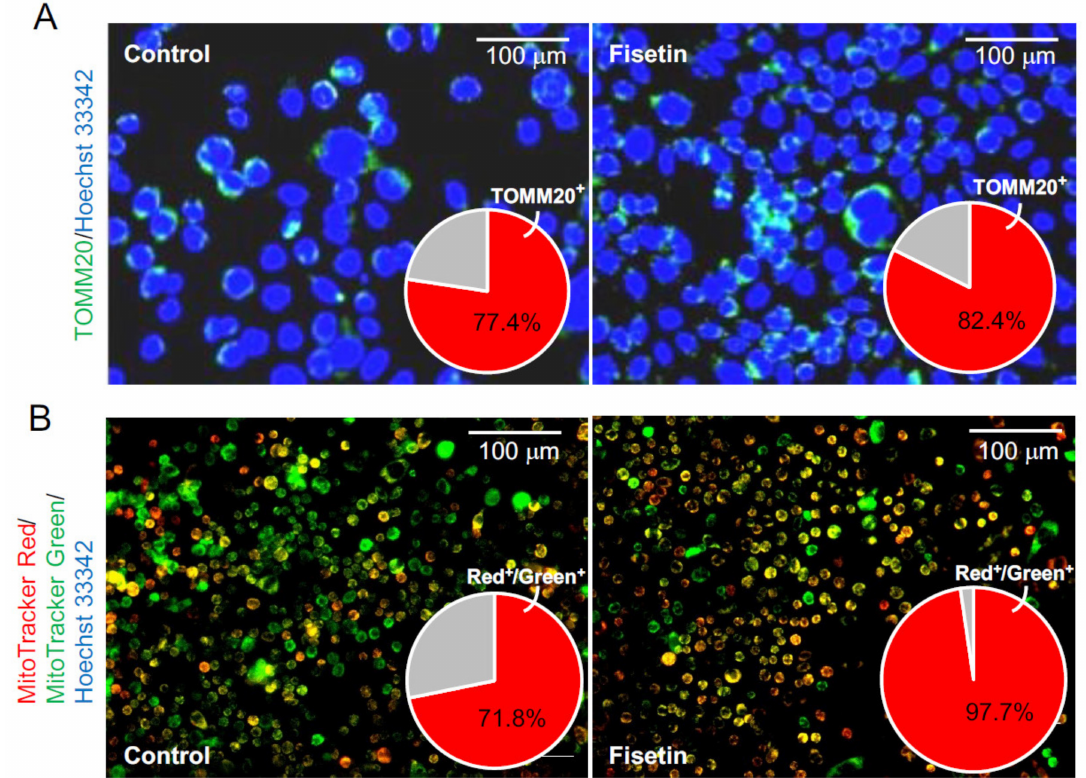
Figure 5. Effects of exosomes derived from fisetin-treated keratinocytes on the mitochondria in HFSCs. ( A ) TOMM20 + cells in HFSCs were detected by immunocytochemistry using anti-TOMM antibody. The number of TOMM20 + cells (red in pie chart) was determined using IN Cell Analyzer 2200. ( B ) Mitochondria in HFSCs were detected by immunocytochemistry using specific probes (MitoTracker Red CMXRos and MitoTracker Green FM). The relative number of cells harboring active mitochondria (yellow cells in photo; red in pie chart) was determined using IN Cell Analyzer